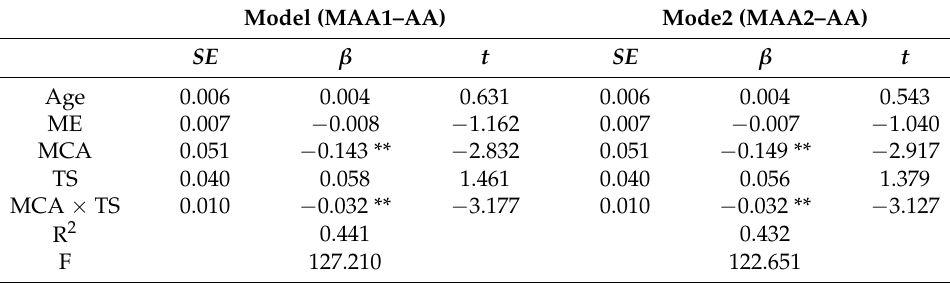
Table 3. Test of the moderating effect of teacher support (N = 1139).